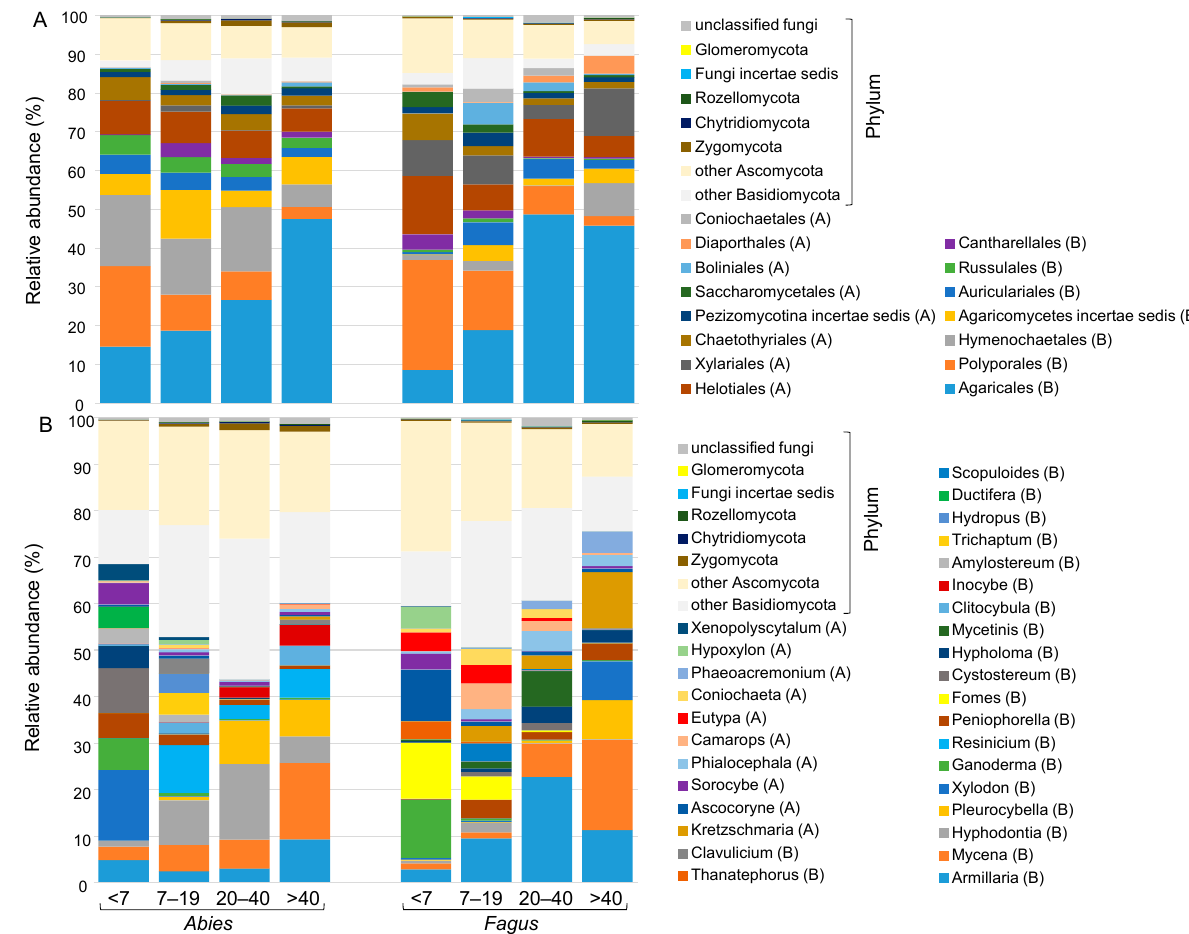
Figure 4. Relative abundances of fungal taxa in the coarse woody debris of Abies alba and Fagus sylvatica in the Salajka natural forest at the order level ( A ) and at the genus level ( B ). Abbreviations: A: Ascomycota; B: Basidiomycota. Only genera and orders with at least 3% relative abundance in one of the treatments were specified, and all others were classified to the phylum level.